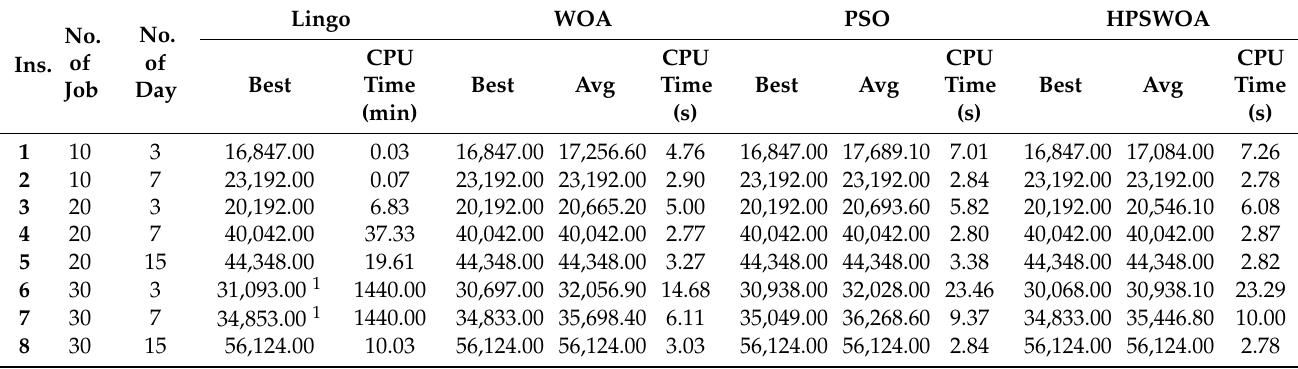
Table 4. Static problem results for Lingo, WOA, PSO, and HPSWOA.